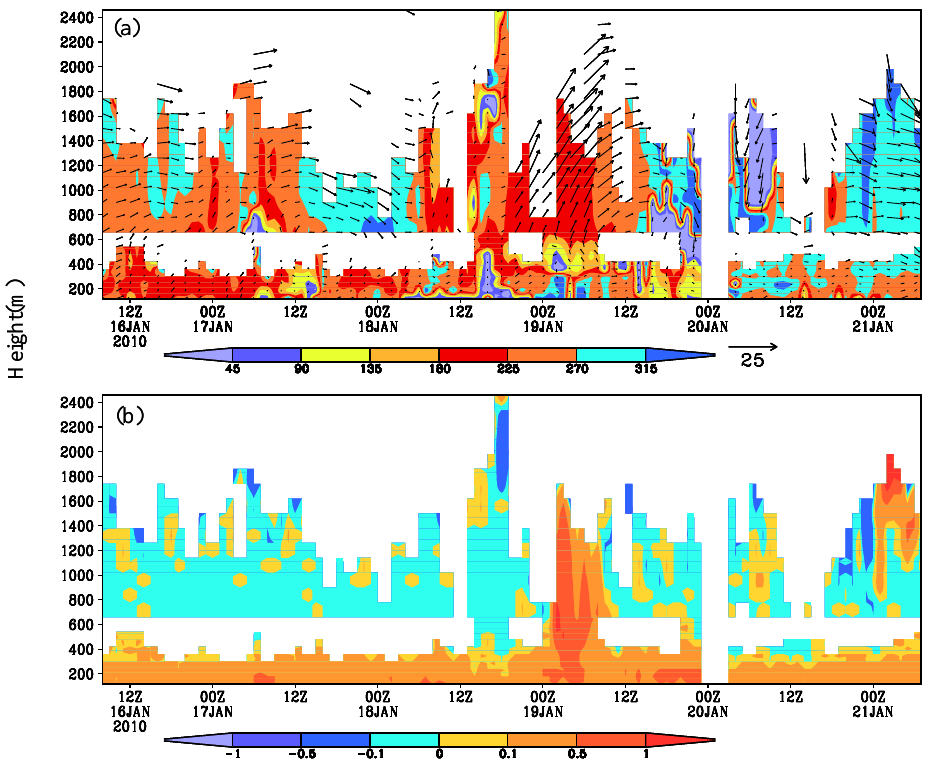
Fig. 9. The lidar measurement of wind profile in the Beijing region from 16 to 21 January. (a) horizontal wind vectors and wind direction Fig.9. The lidar measurement of wind profile in Beijing region from January 16 to 21. 2 (shaded); (b) vertical winds (ms − 1 ) (a) horizontal wind vectors and wind direction (shaded); (b) vertical winds (m s -1 ). 3